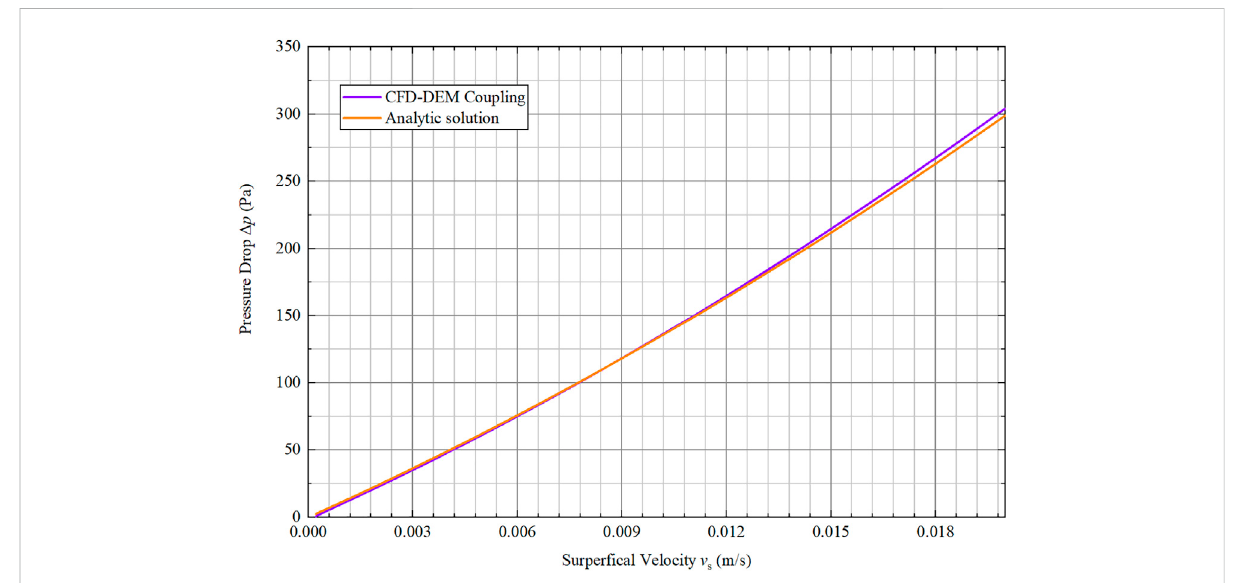
FIGURE 3 Pressure drop contrast with the analytical solution (Ergun equation).